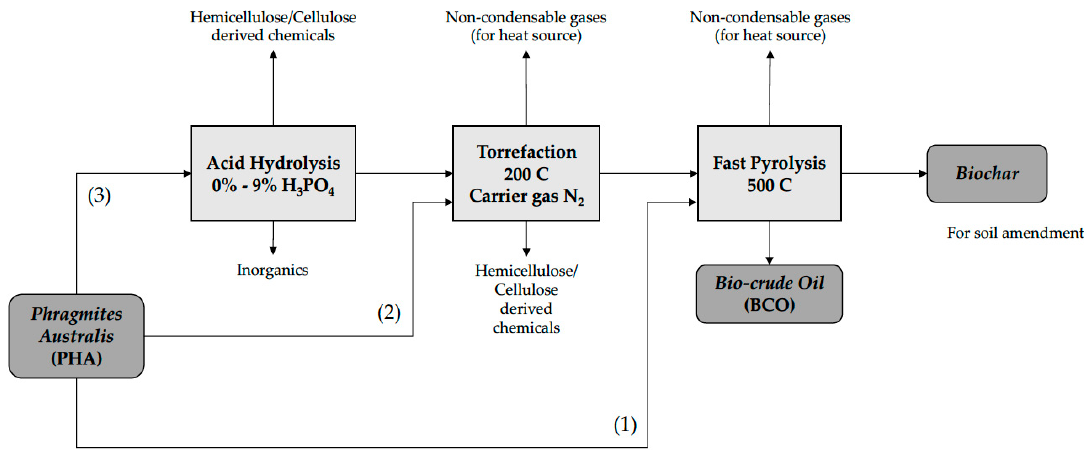
Figure 1. Studied process routes for converting Phragmites australis to bio-oil and biochar using pyrolysis. (1) Direct fast pyrolysis, (2) torrefaction + fast pyrolysis, and (3) Acid hydrolysis + torrefaction + fast pyrolysis.